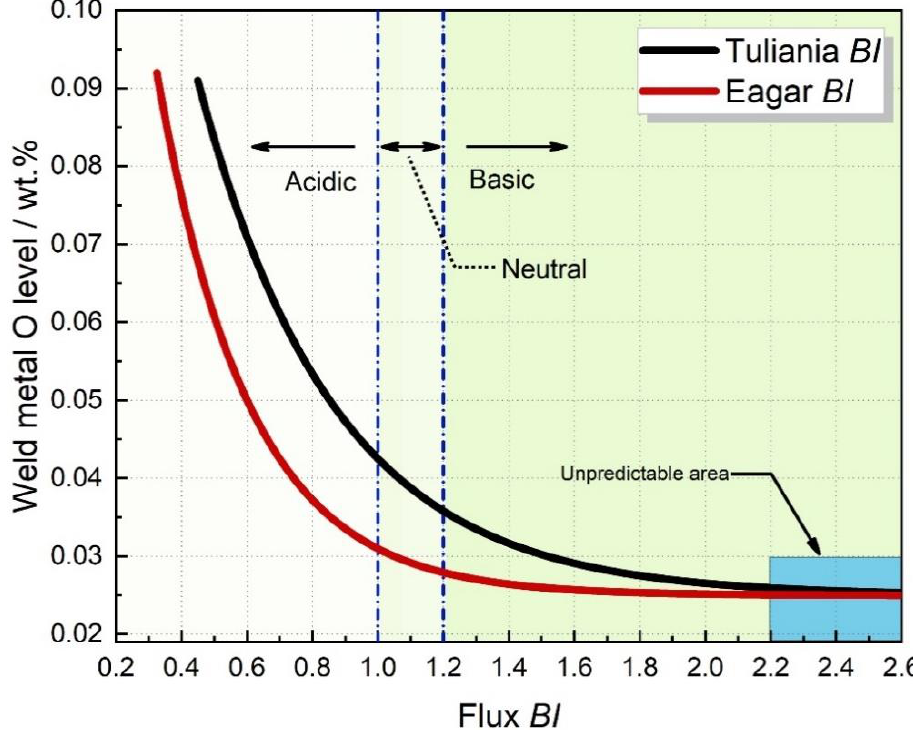
Figure 1. Predicted WM O level as a function of flux BI.